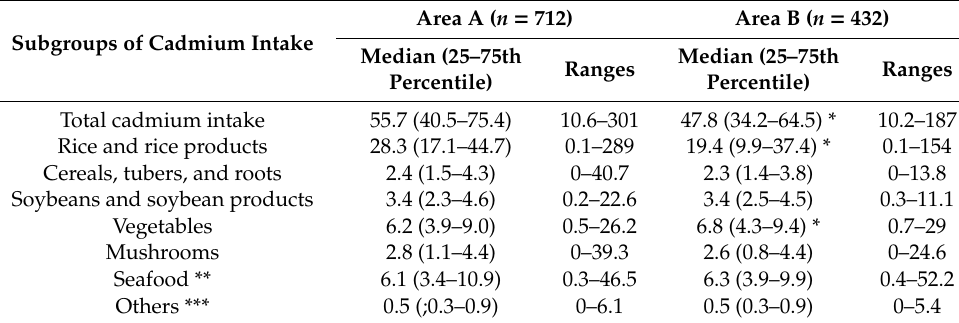
Table 12. Daily cadmium intake per person ( µ g / day) in female farmers in areas A and B.